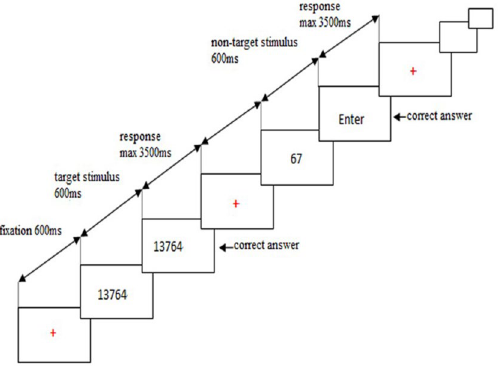
Figure 7. The task flow diagram for a sample stimulus. Stimulus presentation occurred after presentation of a fixation